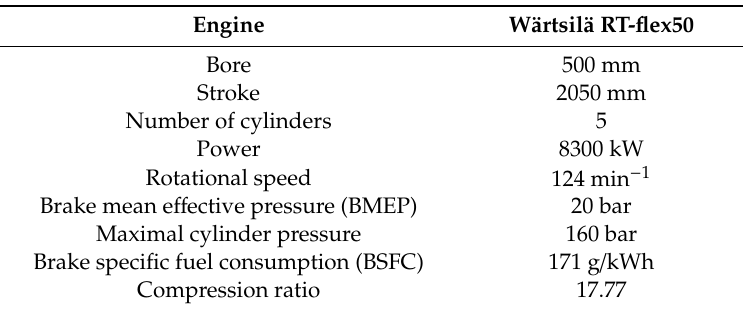
Table 1. Technical data of the Wärtsilä RT-flex50 engine.